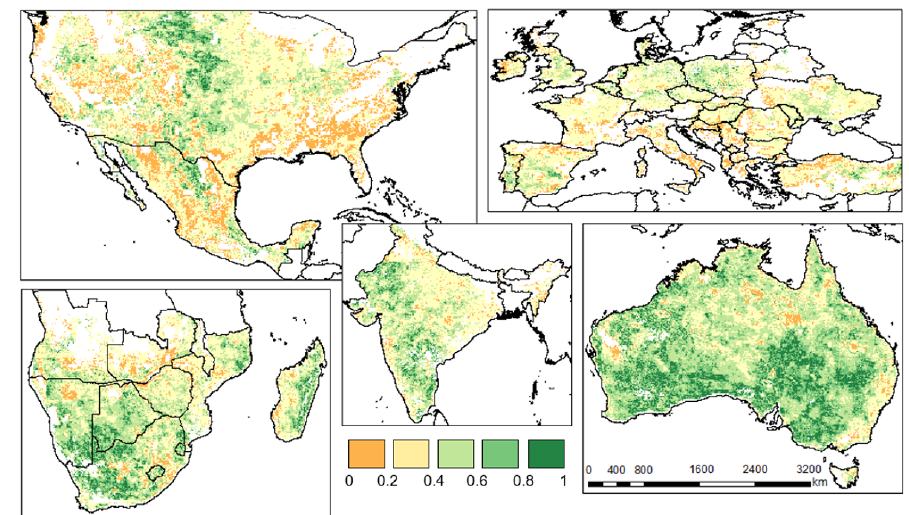
Figure 11. Maps representing the ensemble mean weighting factor for the CCI dataset according to the error maps derived from the TC